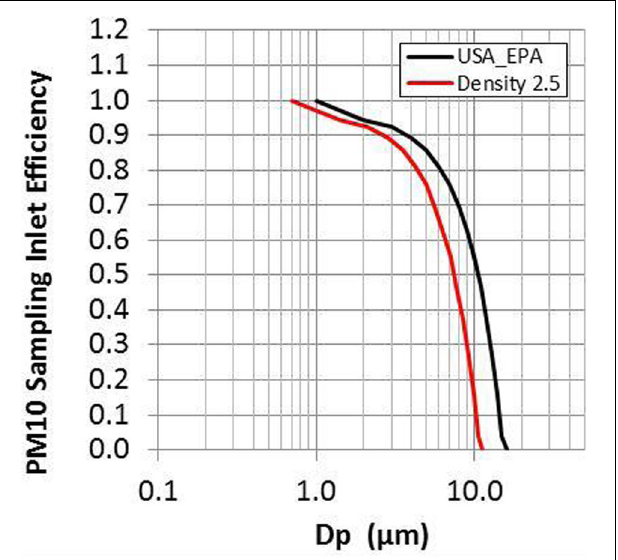
FIGURE 1 | PM10 Sampling inlet efficiency curve in accordance with the USA EPA regulations, expressed originally in terms of aerodynamic equivalent sizes, and for dust aerosol particles having a specific mass density ρ = 2 . 5g.cm − 3 and a Dynamic Shape Factor χ = 1 .